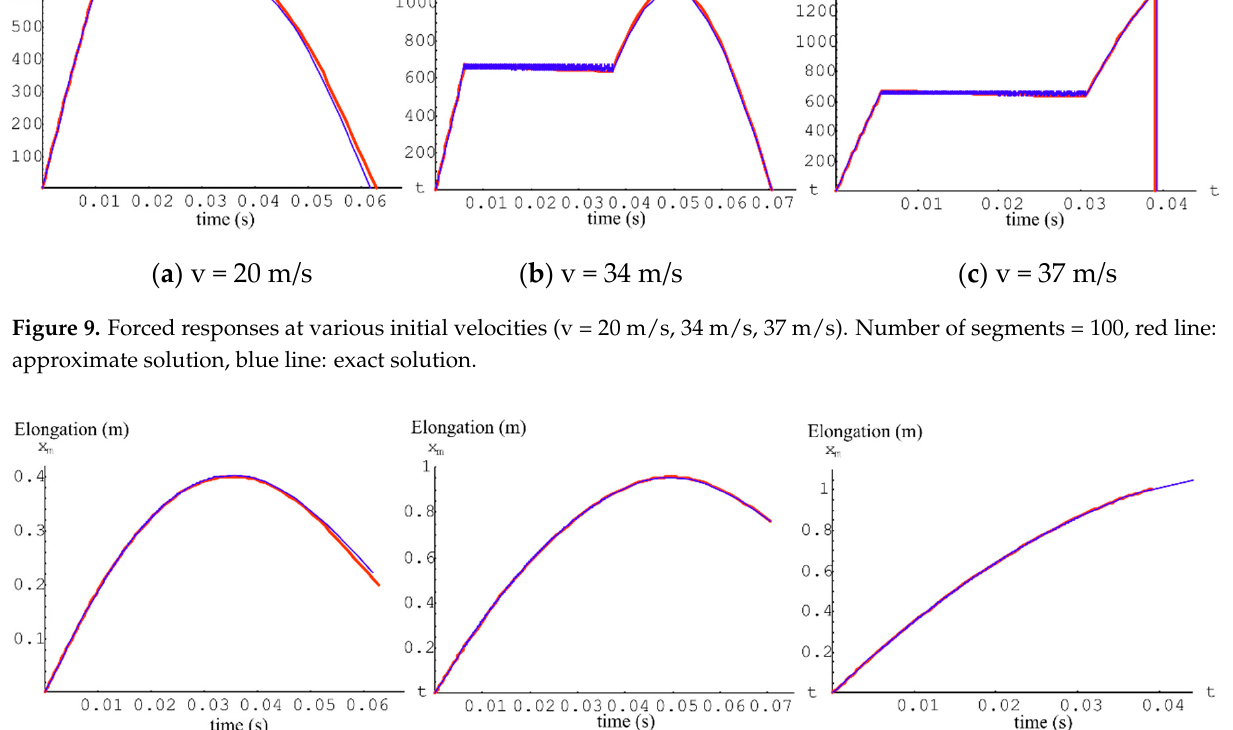
Figure 10. Elongations at various initial velocities (v = 20 m/s, 34 m/s, 37 m/s). Number of segments = 100, red line: approximate solution, blue line: exact solution.